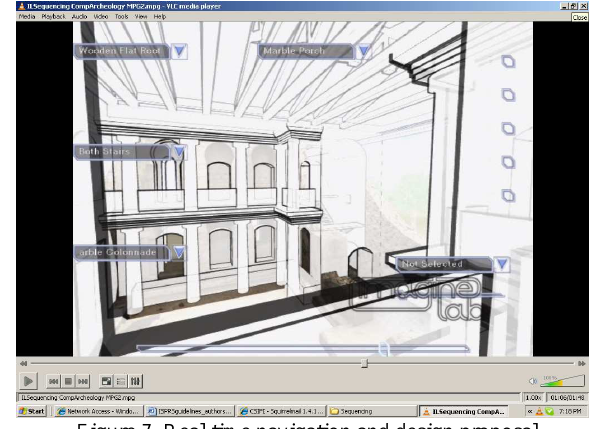
Figure 7. Real time navigation and design